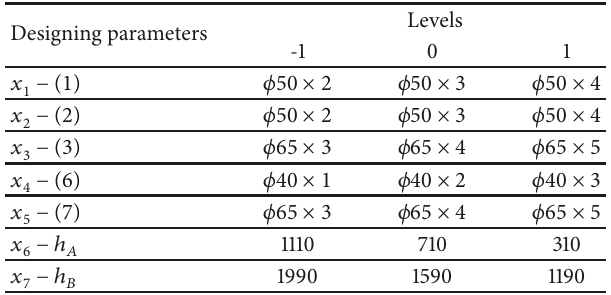
Table 1: Levels of designing parameters and the corresponding actual values (unit: